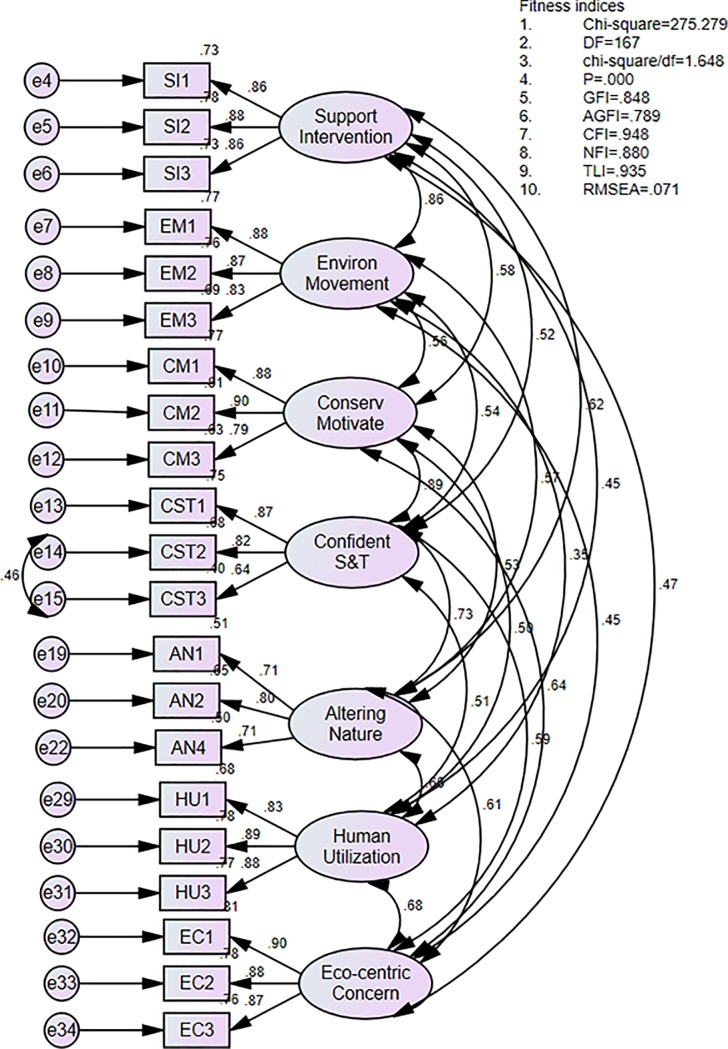
Final structural model of the 7-factor model; 21 items.